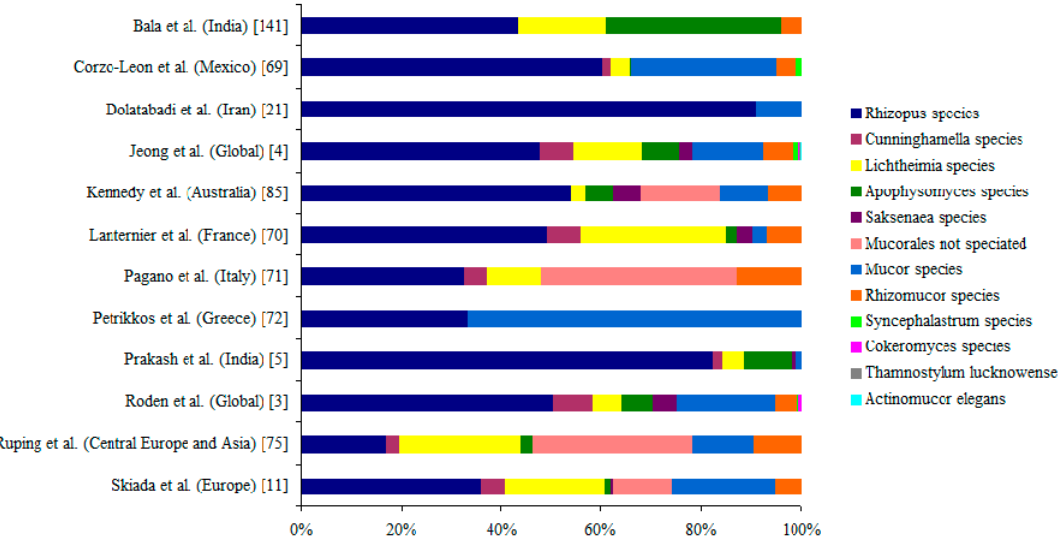
Figure 4. Causative agents of mucormycosis.